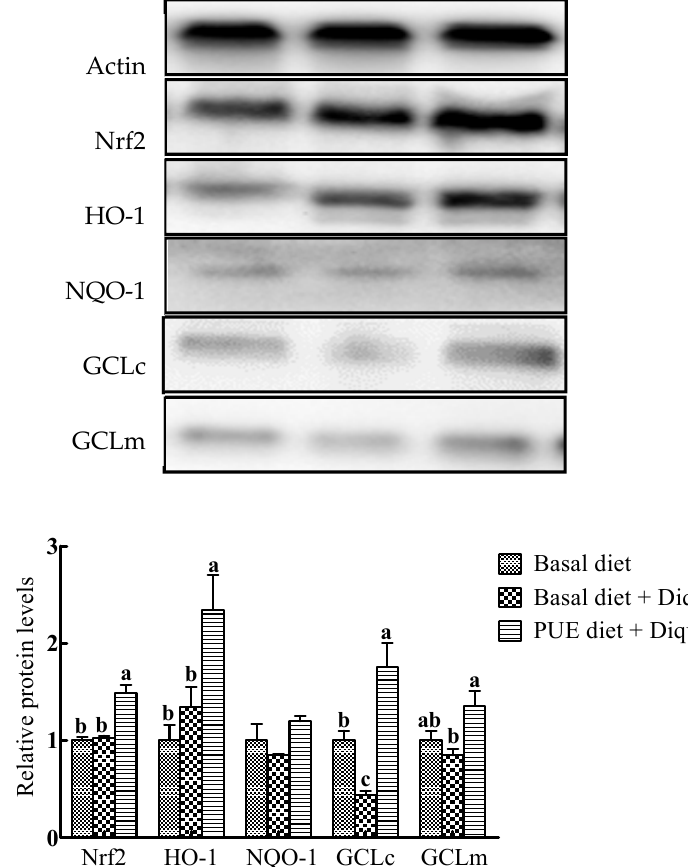
Figure 3. Representative Western blot images and the relative protein levels of NF-E2-related factor 2 (Nrf2), heme oxygenase-1 (HO-1), NADH dehydrogenase quinone 1(NQO-1), glutamate–cysteine ligase catalytic subunit (GCLc) and glutamate–cysteine ligase modifier subunit (GCLm) in the jejunum of piglets. The protein expressions were expressed relative to the values of the piglets on the basal diet treatment. Data are expressed as means ± SEM, n = 8. a–c Values with di ff erent lowercase letters are di ff erent ( p < 0.05).